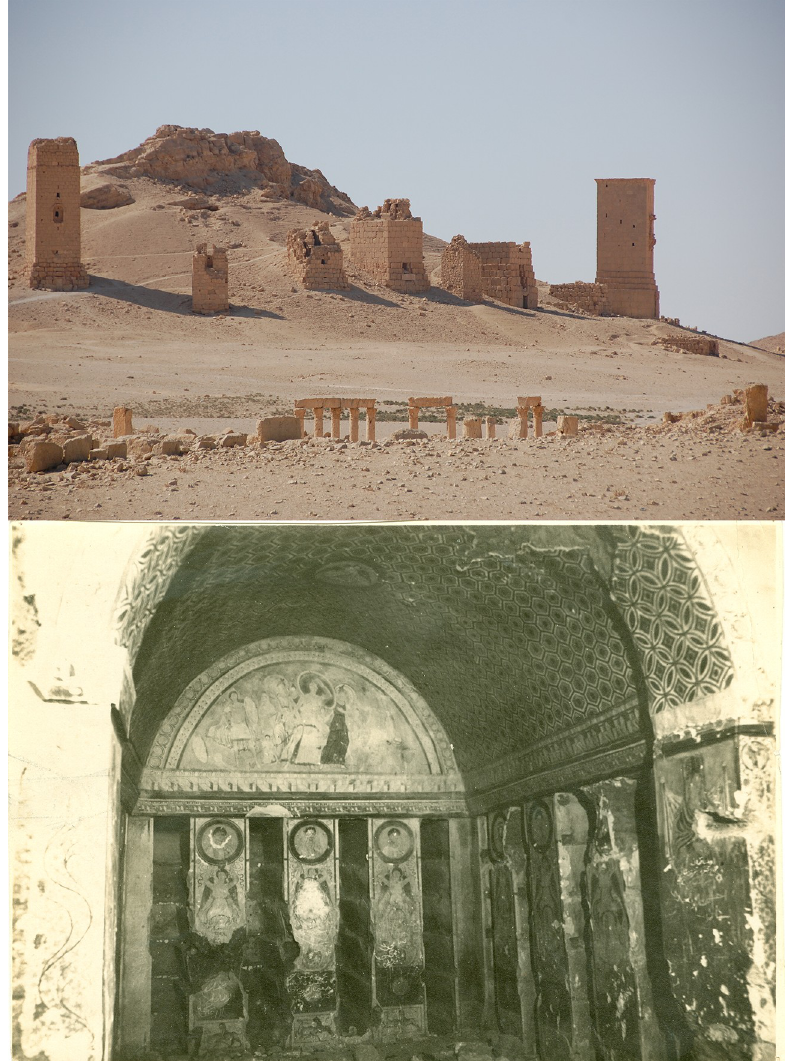
Fig 5. Upper row: View of tower tombs. Image © Rubina Raja. Lower row: view of the Hypogeum of the Three Brothers. Image © Rubina Raja and Palmyra Portrait Project, Ingholt Archive at Ny Carlsberg